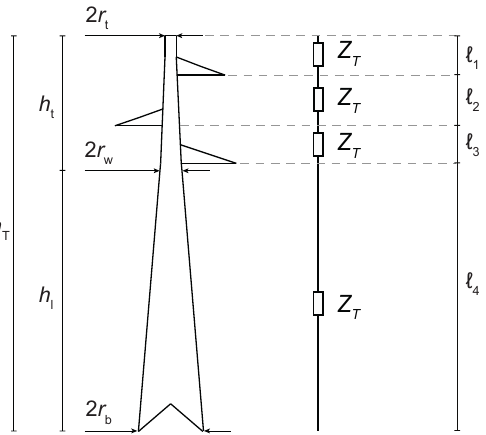
Figure 3. Cascade of uniform and lossless transmission lines modeling the corresponding sections in which the tower is